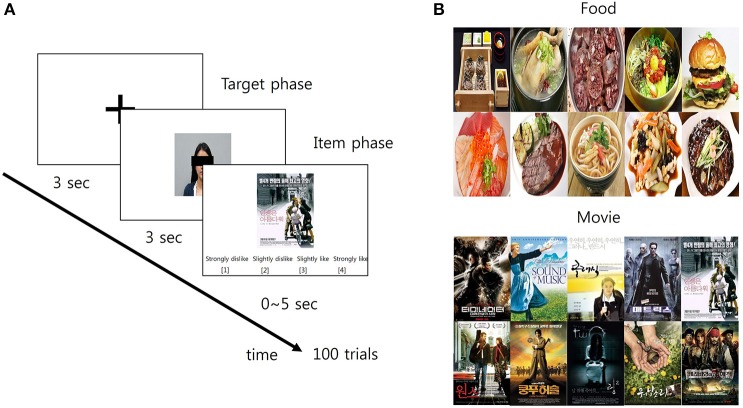
The schematic diagram of the preference prediction task. (A) Each trial began with the 3-s fixation period. Then, the facial picture of a target person whose preference was predicted later appeared on the screen for 3 s (target phase). Following the first phase, the picture of an item over which the preference of the target person was predicted appeared on the screen for 5 s (item phase). Within this 5-s period, participants predicted the target's preference over the item using a 4-scale response: (1) strongly dislike; (2) slightly dislike; (3) slightly like; and (4) strongly like. (B) The pictures of 10 items in each category (food and movie, respectively) were used in the study.